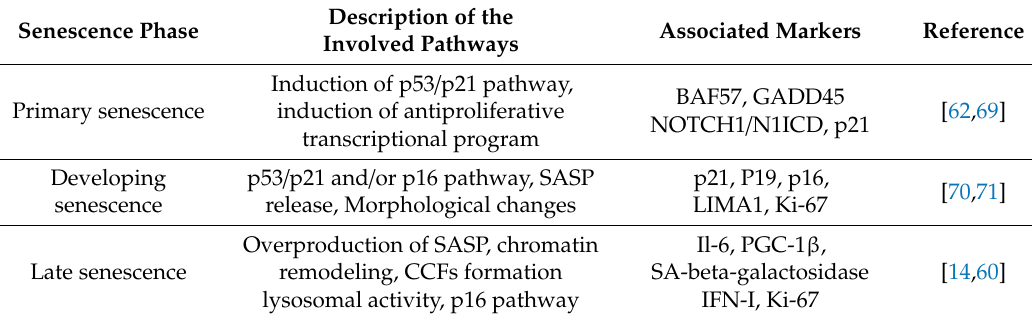
Table 1. Cellular senescence dynamic